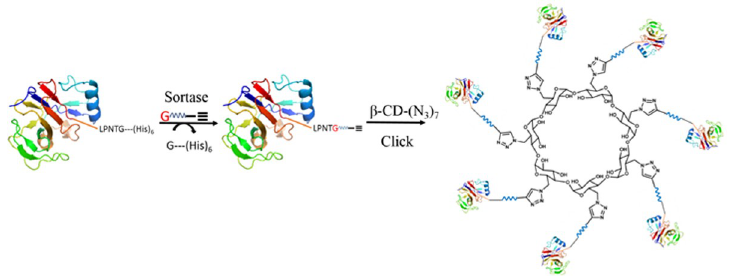
Fig 1. Schematic representation of Sortase—click strategy for the semisynthesis of multivalent protein dendrimers on a cyclodextrin scaffold. A Gly-terminated alkyne moiety can be installed at the C-terminus of any recombinant protein engineered with a LPNTG pentapeptide motif by sortase-mediated peptide ligation. The alkyne- labelled protein is then clicked with per-6-deoxy-6-azido- β -cyclodextrin [ β -CD(N 3 ) 7 ] through Huisgen cycloaddition reaction.